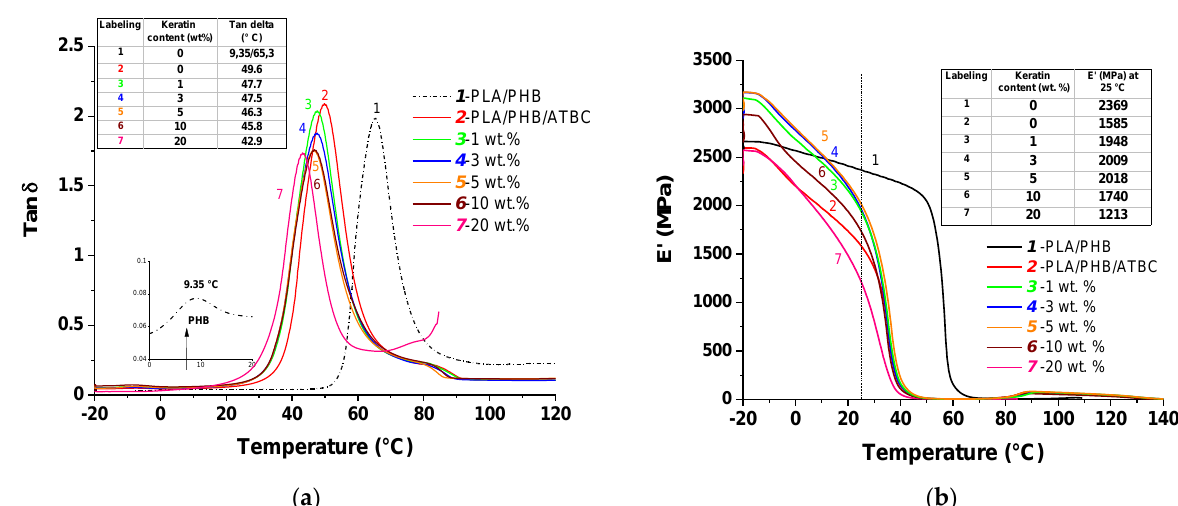
Figure 5. ( a ) Values of tensile properties ( ε B and σ M ) and Young’s modulus (inserted table) and ( b ) stress–strain curves for PLA/PHB/ATBC blend and its keratin composites with different keratin contents varying from 1 to 20 wt%. The inset of Figure 5b shows the stress–strain curve for PLA/PHB blend.